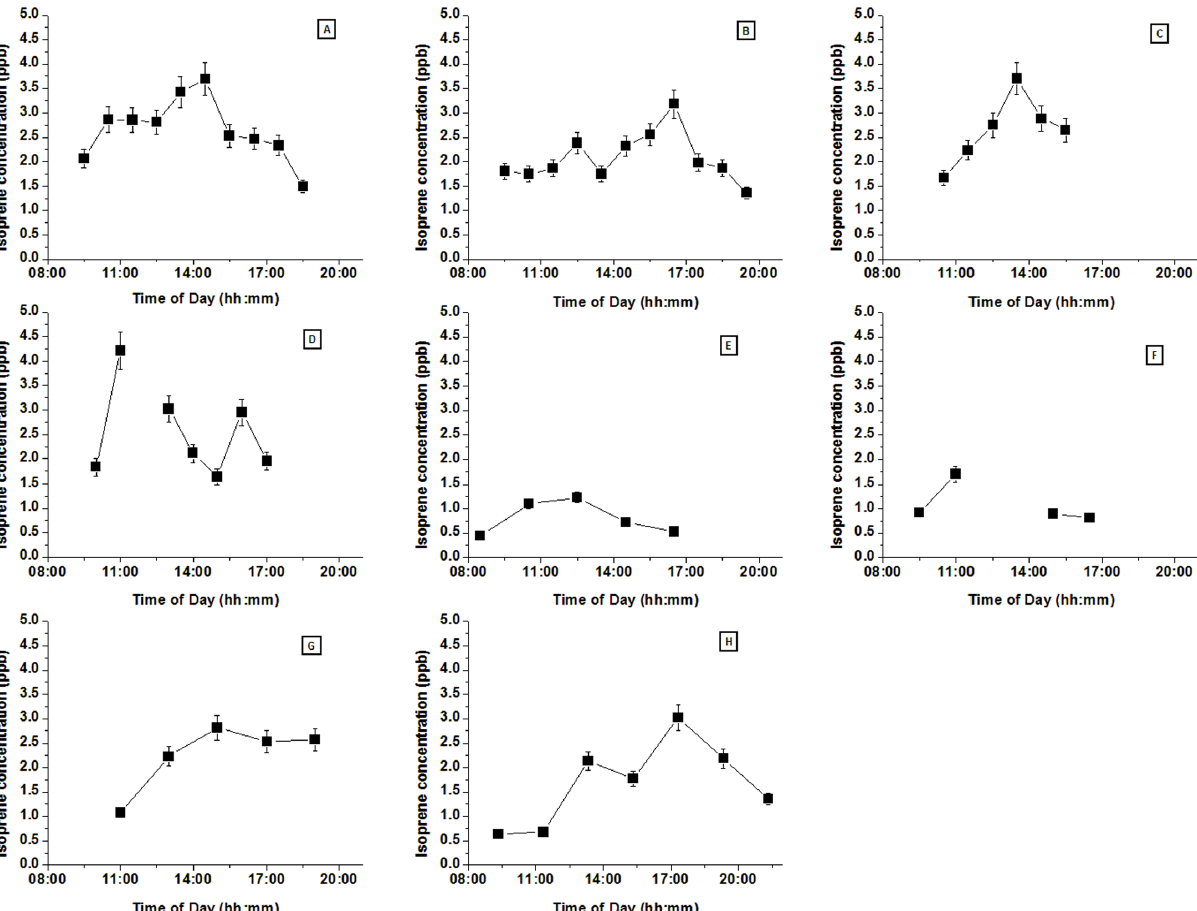
Fig. 3. Isoprene concentrations (in ppbv) measured during the 2009 CABINEX campaign via DEA. Data show daily isoprene concentrations during the eight intensives the DEA was deployed. Letters assigned to plots in Fig. 3 and all subsequent figures represent the days of measurement: A=9 July, B=14 July, C=20 July, D=21 July, E=26 July, F=30 July, G=31 July, H=4 August. Each data point represents the midpoint of the averaging period, which ranged from 55 to 115min. Error bars represent the propagated uncertainty in the derived concentration (see text for